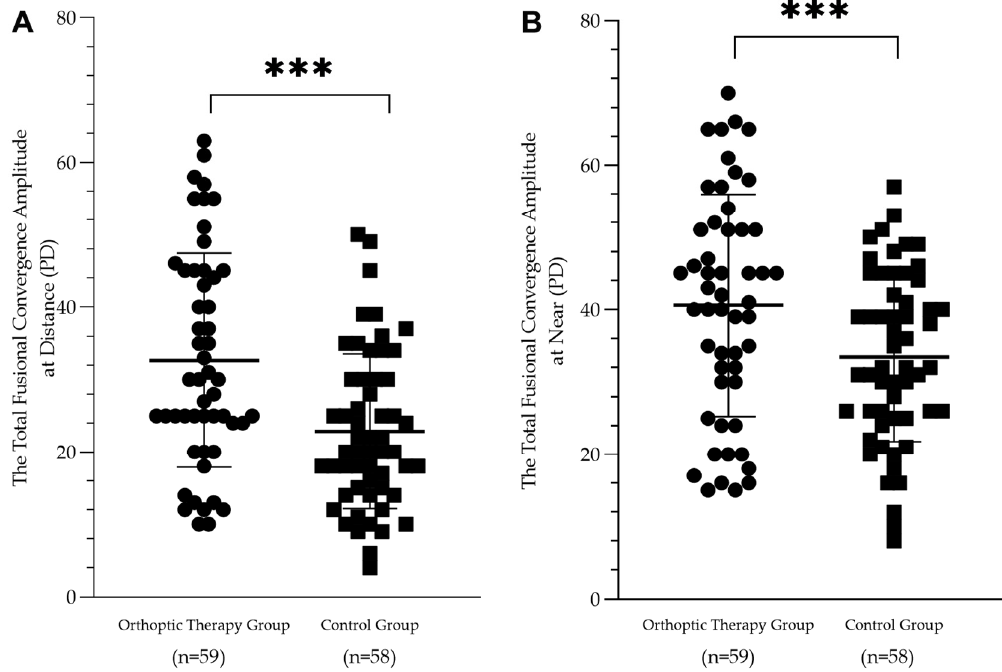
Figure 5. Scatterplots showing the postoperative 12-month total fusional convergence amplitude in the orthoptic therapy group and the control group at distance ( A ) and at near ( B ). There was a significant difference between the two groups (*** p < 0.001).